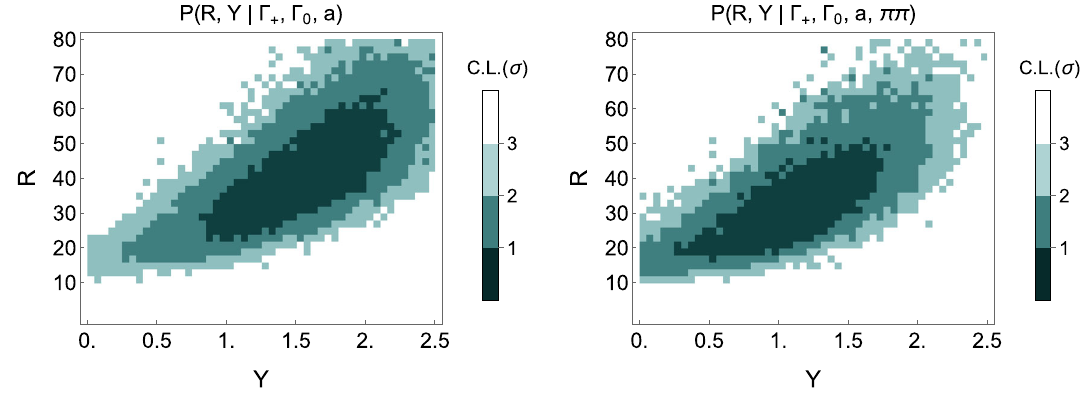
Fig. 8 Probability density P ( R , Y | data ) for R free, Z integrated out. Left: η → 3 π data. Right: η → 3 π and ππ scattering